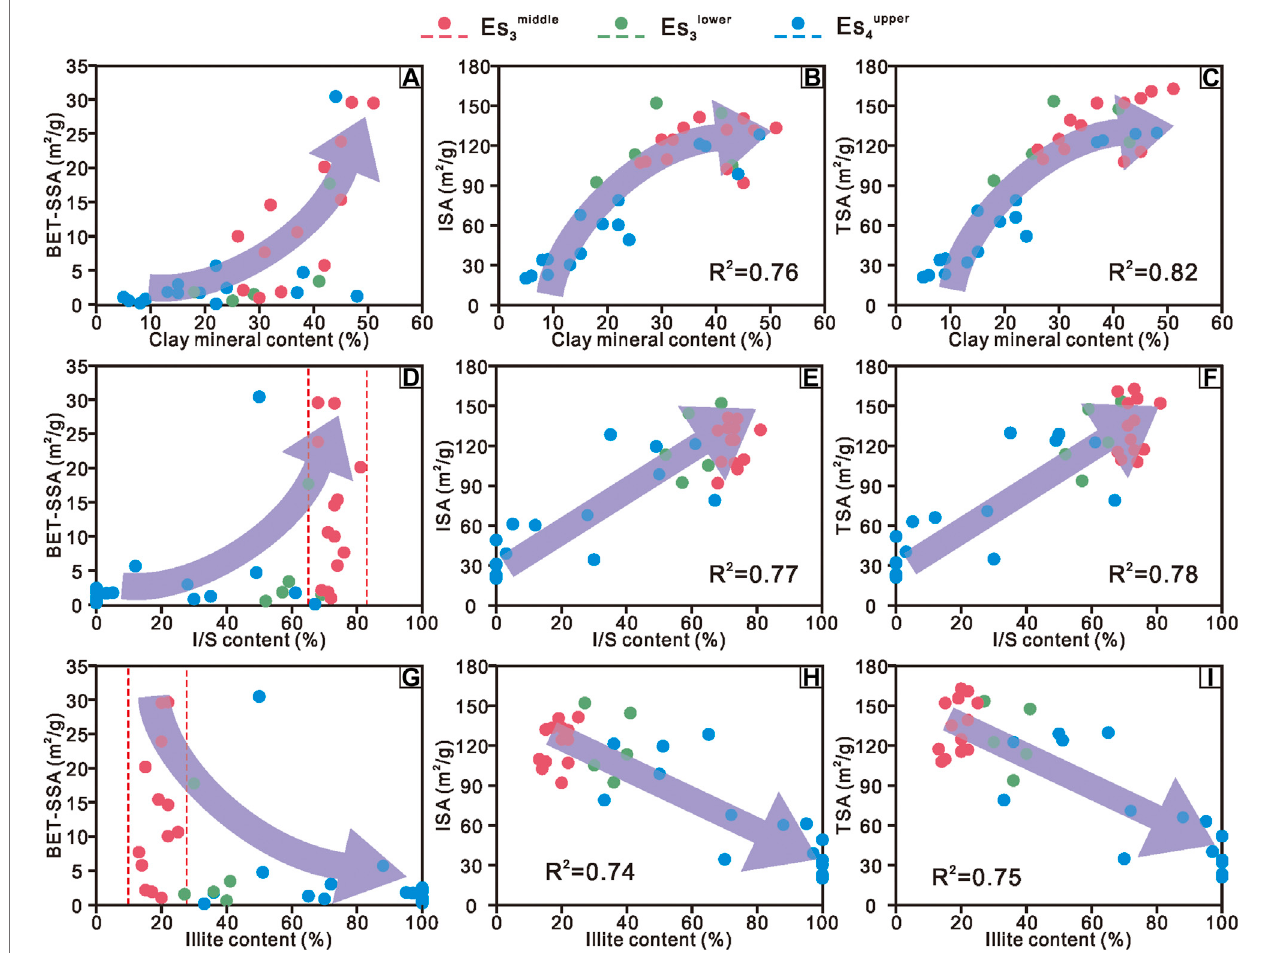
FIGURE9 | Relationships between surface areas and clay mineral contents (A – C) , I/S contents (D – F) and illite (G – I) contentsof the shales from different sections.